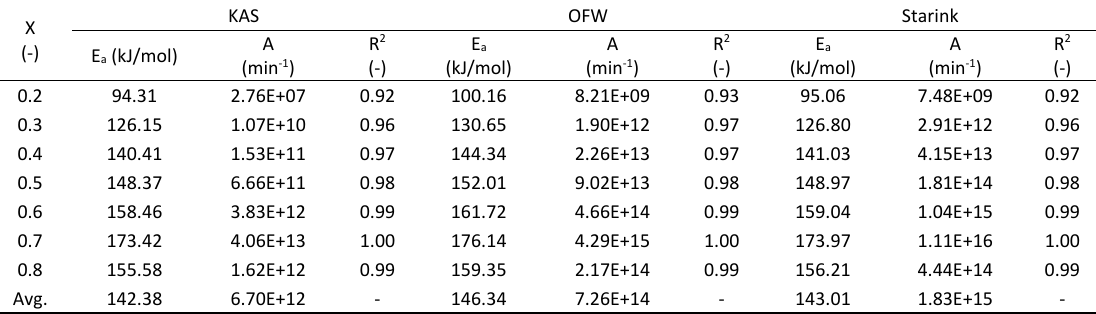
Table 8: Thermokinetic factors of pellets for three models